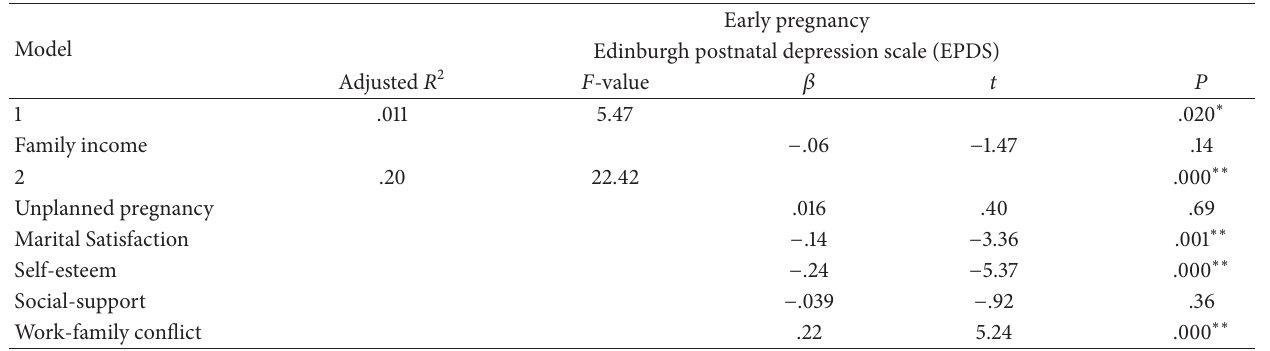
Table 5: Hierarchical multiple regression analysis of significant psychosocial risk factors for EPDS scores in early pregnancy.